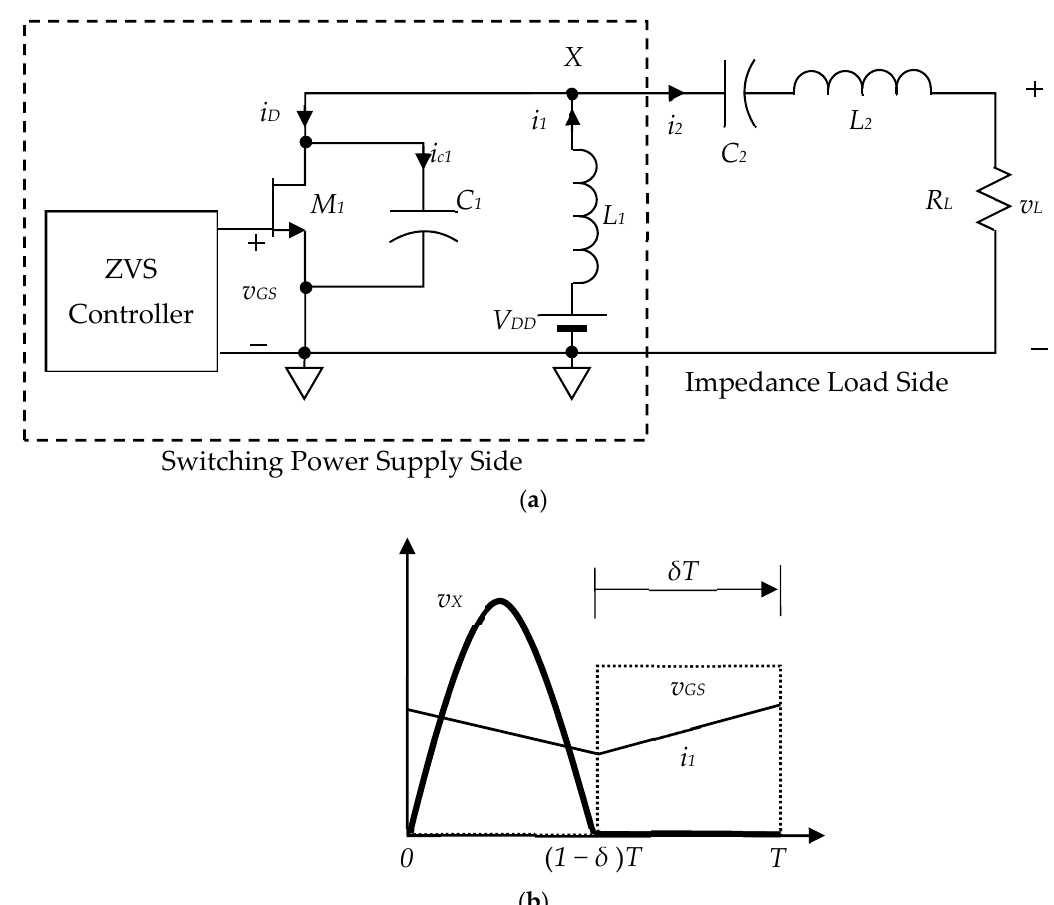
Figure 2. Class-E amplifier of the PTU. − Figure 2. ( a ) Class-E amplifier of the PTU; ( b ) Pulse Width Modulation (PWM) control of D-mode GaN HEMT.